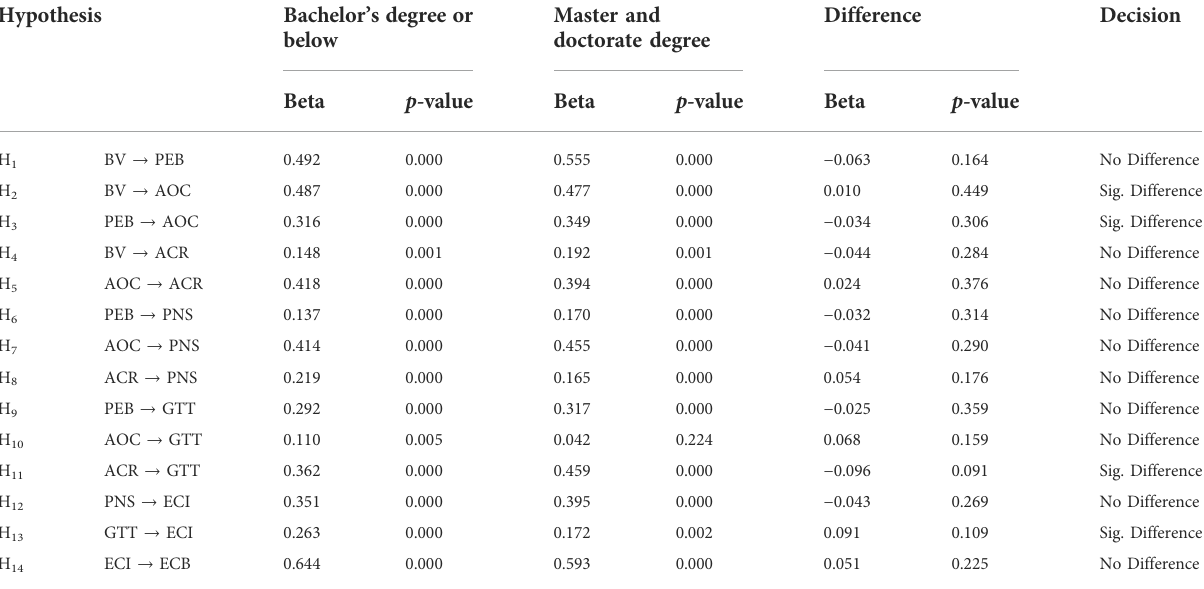
TABLE 6 Multi-group analysis —